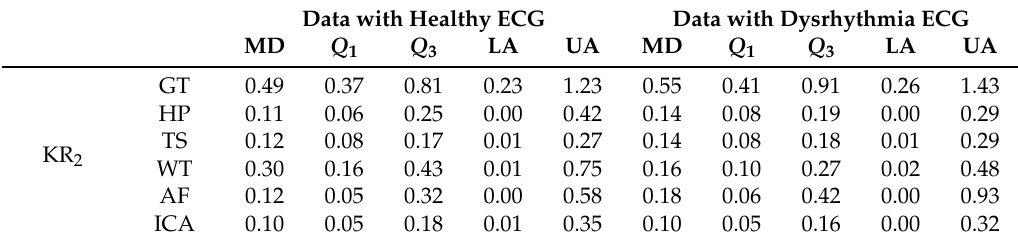
Figure 8. Boxplot of the RMSE results for different ECG removal methods with healthy ECG interference: ( a ) RMSE in KR 2 ; ( b ) RMSE in ARV; ( c ) RMSE in MF. Data are presented as median, the first and third quartiles, and the upper and lower adjacent. + indicates the outliers (whisker length = 1.5). ** indicates significant ( p < 0.05) difference from all other methods, and * indicates significant ( p < 0.05) difference between two methods. Table 2. RMSE results for KR 2 , ARV, and